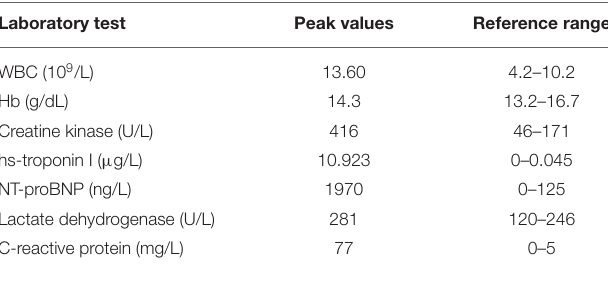
TABLE 1 | Key laboratory findings supporting the